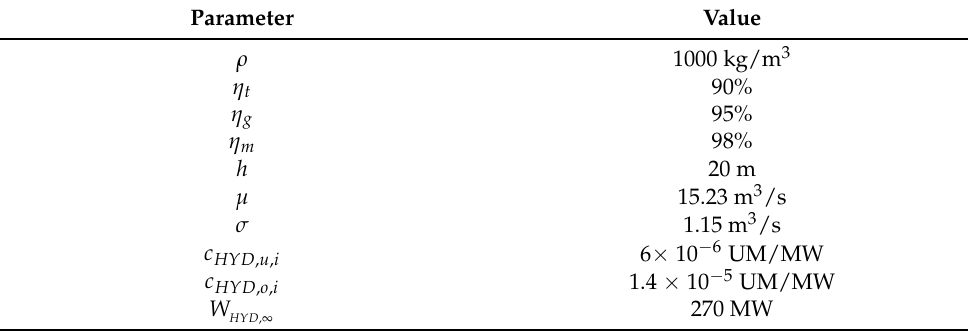
Table 2. Parameters taken for the cost function of the run-of-river hydroelectric plant [5].